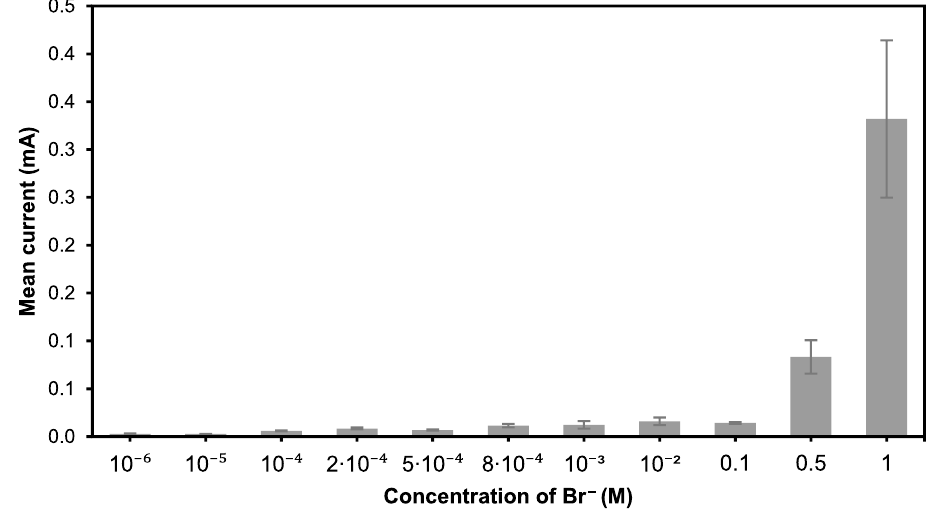
Figure 9. Mean current measured during the first 10 s of WDT. Error bars indicate the standard errors of the means calculated from 10